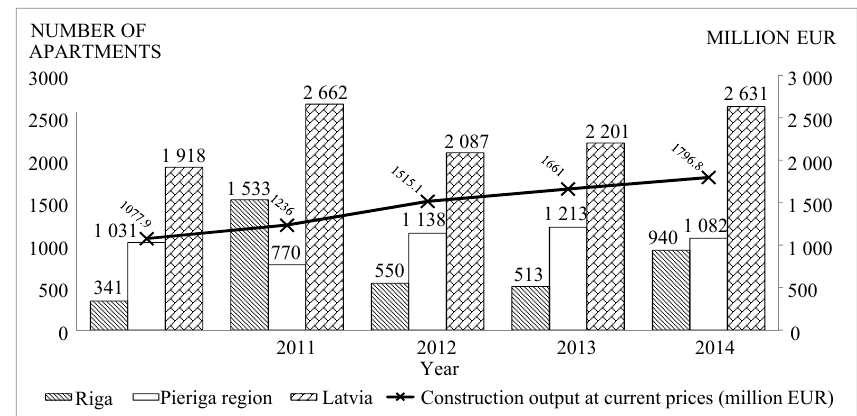
Fig. 3. Construction output changes at current prices and the